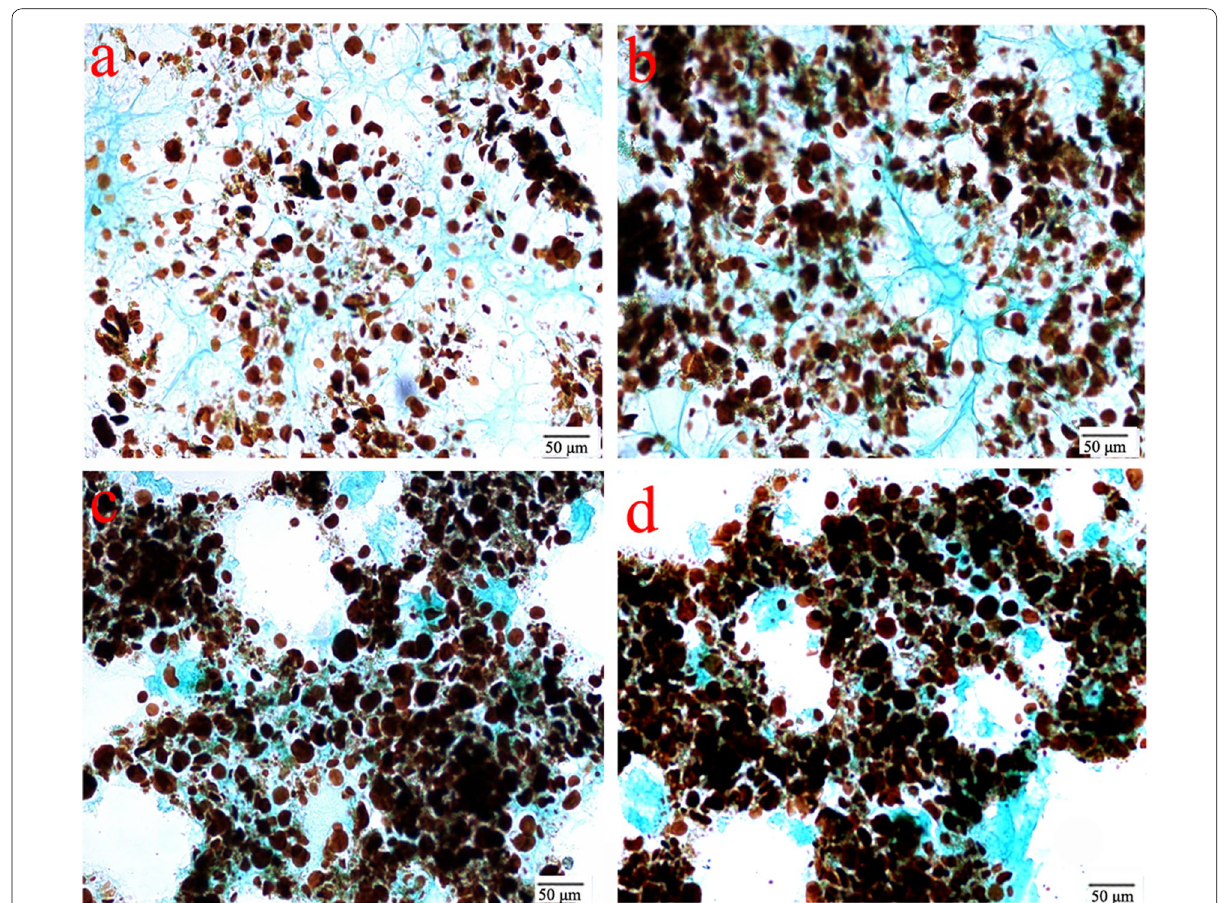
Fig. 4 Microscopy examination of the effect of FB G on proteins and starch granules in the crumbs. a The reference; b 0.025 ml/g; c 0.05 ml/g; d 0.10 ml/g